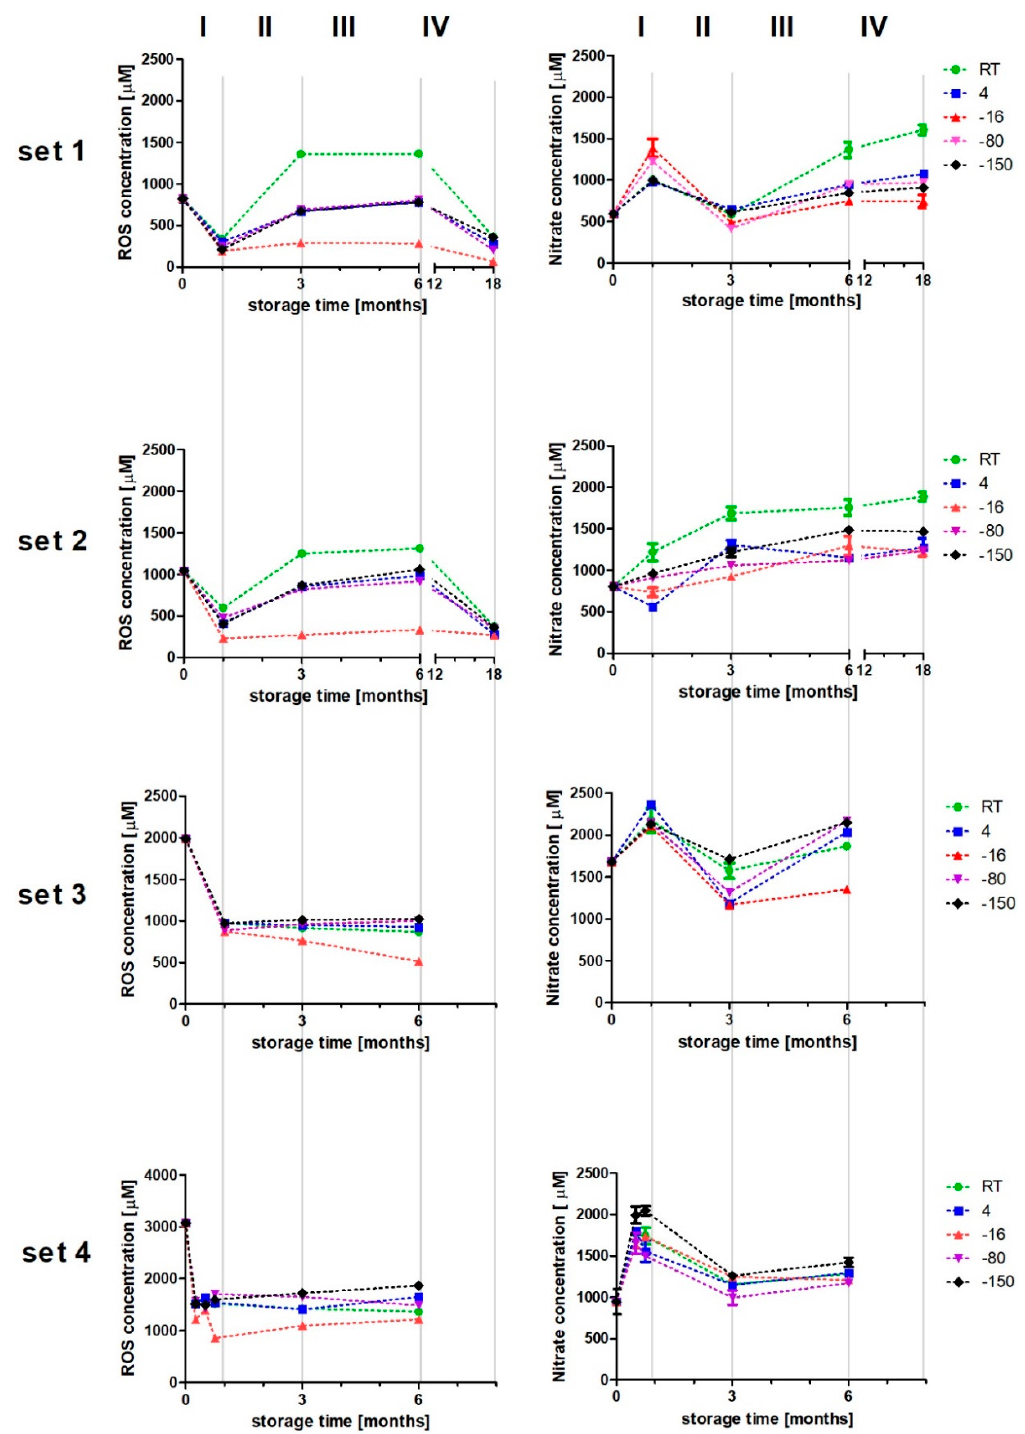
Figure 7. Chemical properties of PAW stored at different temperatures for 6–18 months showing ROS concentrations in the column on the left and nitrate concentrations in the column on the right. Samples were analysed after 1, 3 and 6 months and 18 months (sets 1 and 2). Set 4 was also analysed after 1, 2 and 3 weeks of storage.